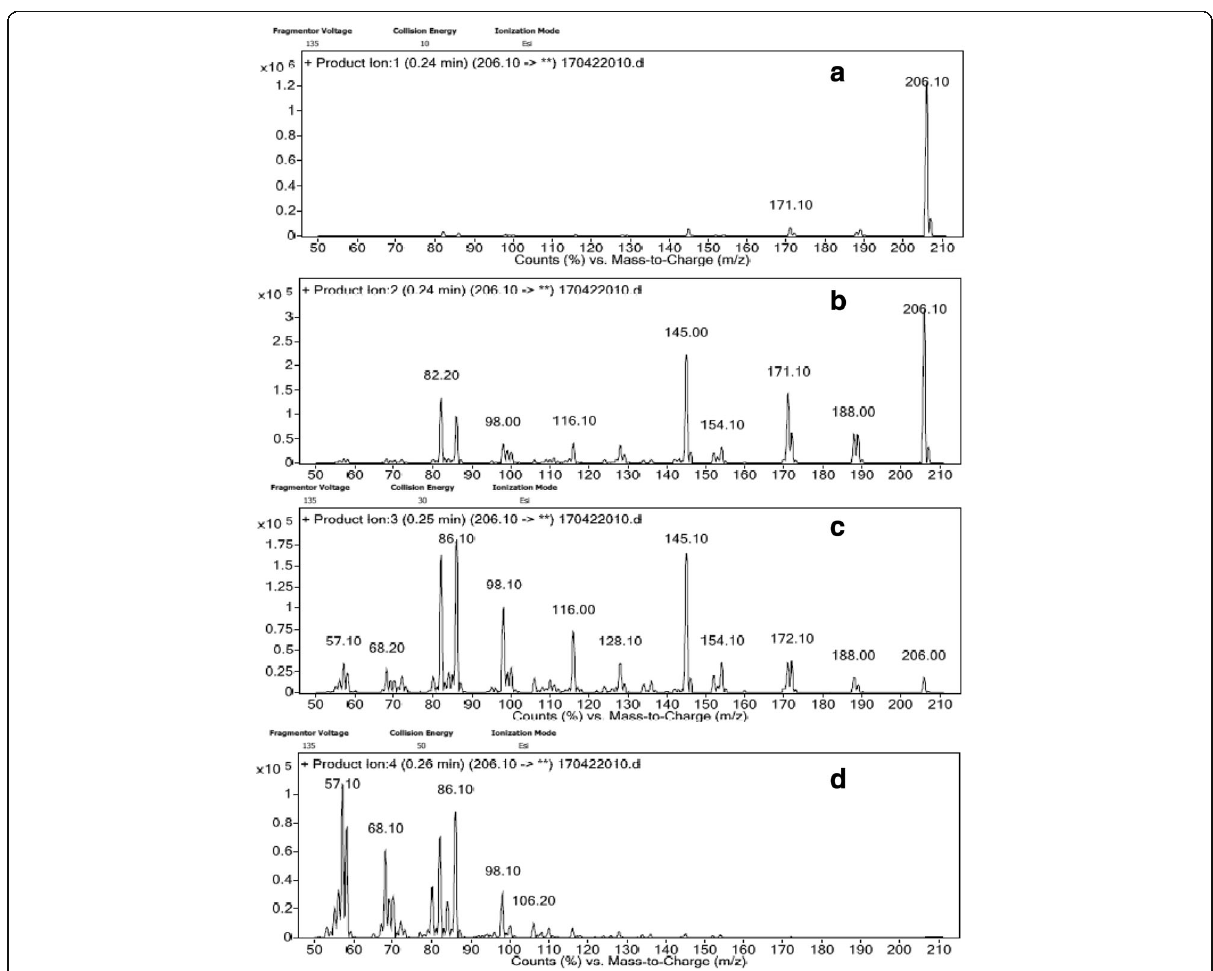
Fig. 11 MS/MS of n-oxide impurity of castanospermin at a 10 eV collision energy, b 20 eV collision energy, c 30 eV collision energy, and d 50 eV collision